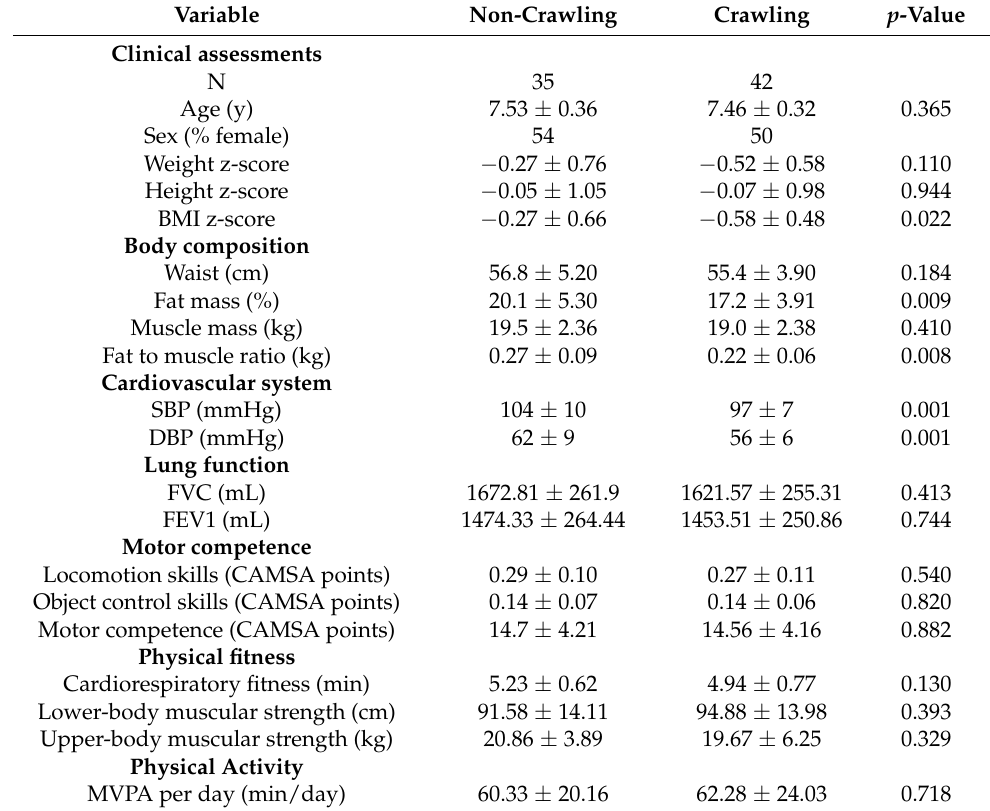
Table 1. Clinical assessments, body composition, cardiovascular system, lung function, motor competence and physical fitness variables in the study subjects ( n = 77) by crawling